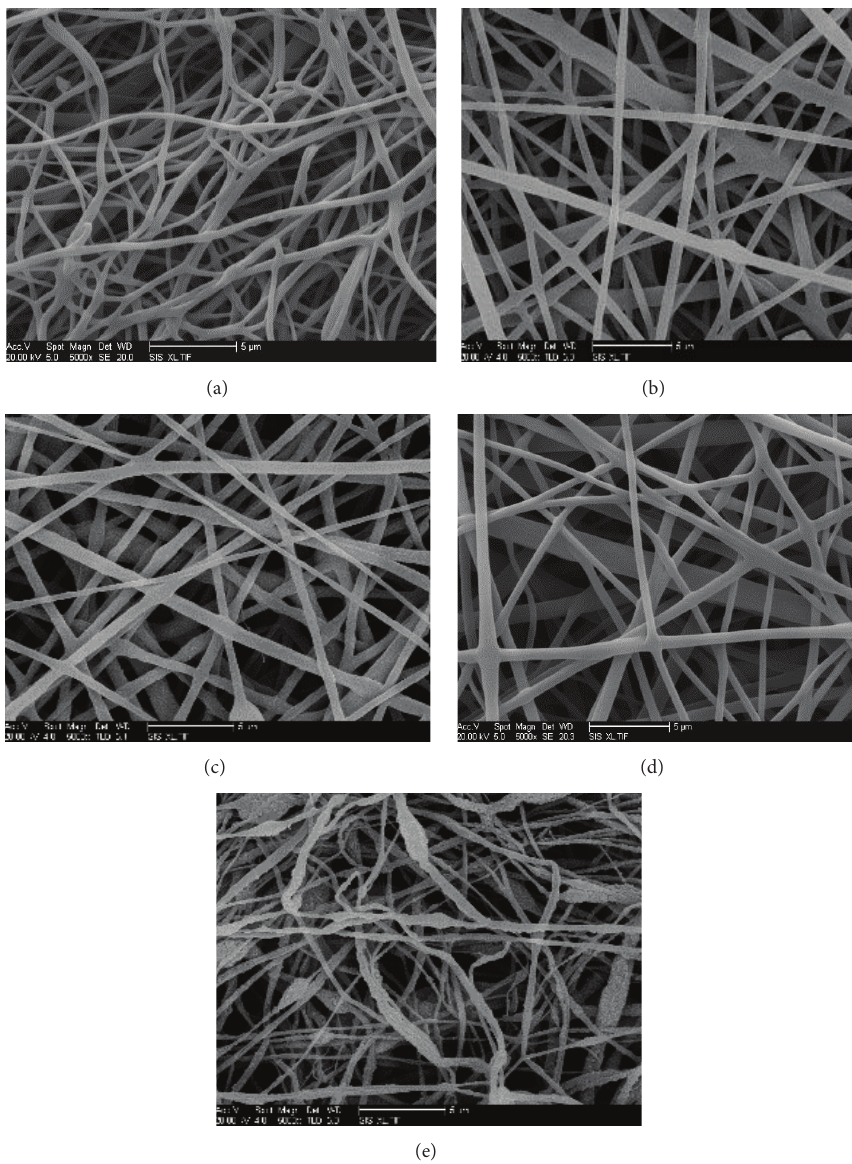
Figure 7: SEM photos of PVDF/PEI composite fiber membrane prepared by electrospinning with the different solvent mass ratio of m(DMF)/m(THF). (a) m(DMF)/m(THF): 9/1; (b) m(DMF)/m(THF): 8/2; (c) m(DMF)/m(THF): 7/3; (d) m(DMF)/m(THF): 6/4; (e) m(DMF)/m(THF):